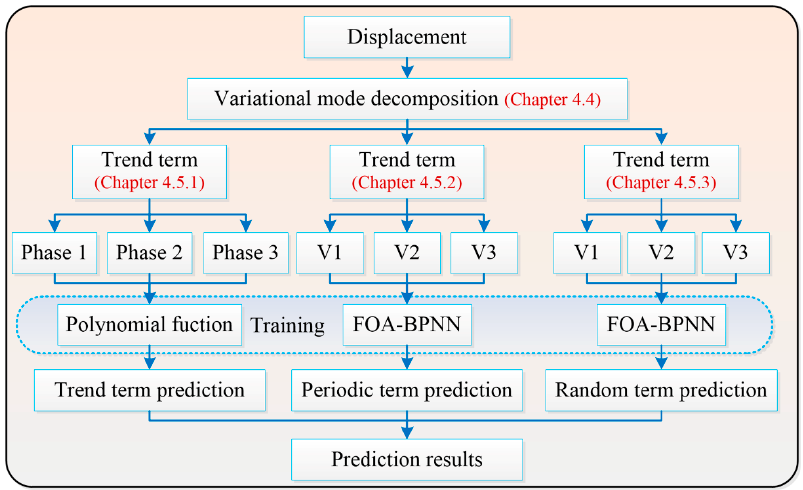
Figure 1. Flow chart of the displacement prediction.